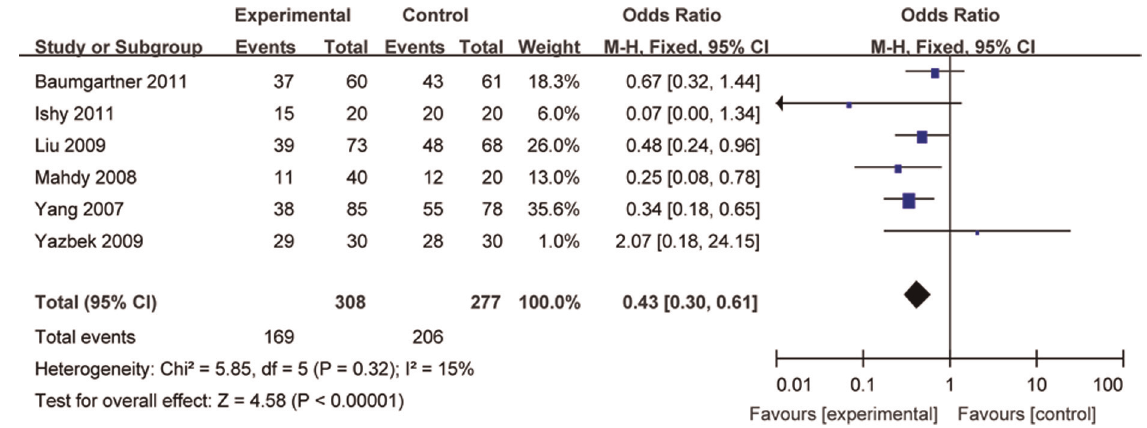
Figure 3 - CS after lowering the level of sympathectomy. CI, confidence interval; CS, compensatory